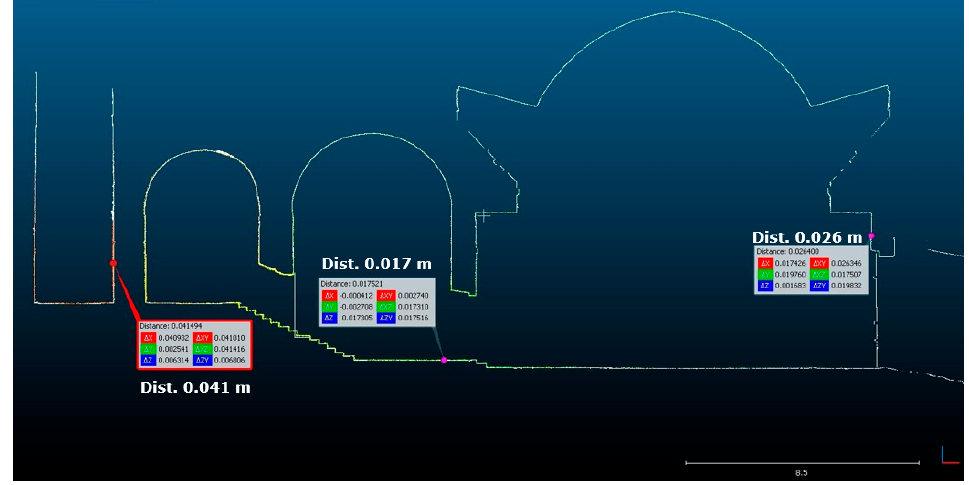
Figure 16. GeoSlam Zeb-Revo, path 1. Cross Section 2 (reference data in white, compared dataset in colour).